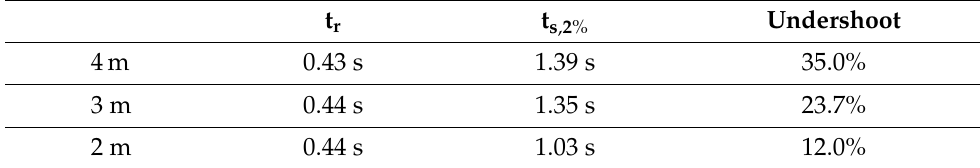
Figure 6. Comparison between the altitude and pitch dynamic for the non-linear MPC with different rise altitudes. Table 4. Height undershoot for different altitudes for the MPC,